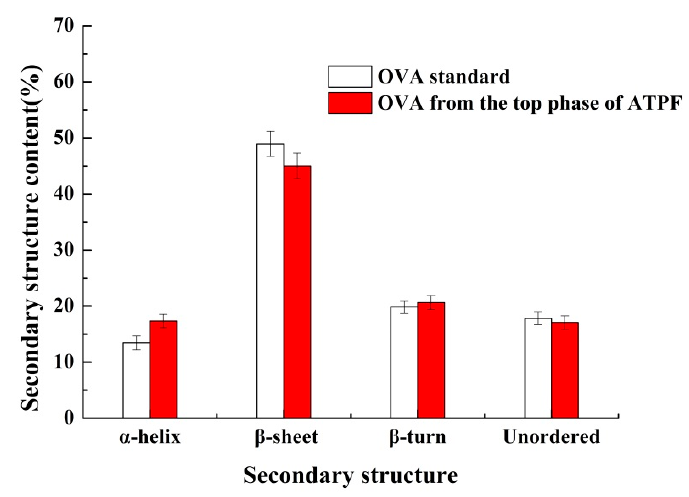
Figure 8. The content of the secondary structure for OVA obtained from di ff erent sources. Figure 8 . The content of the secondary structure for OVA obtained from different sources .